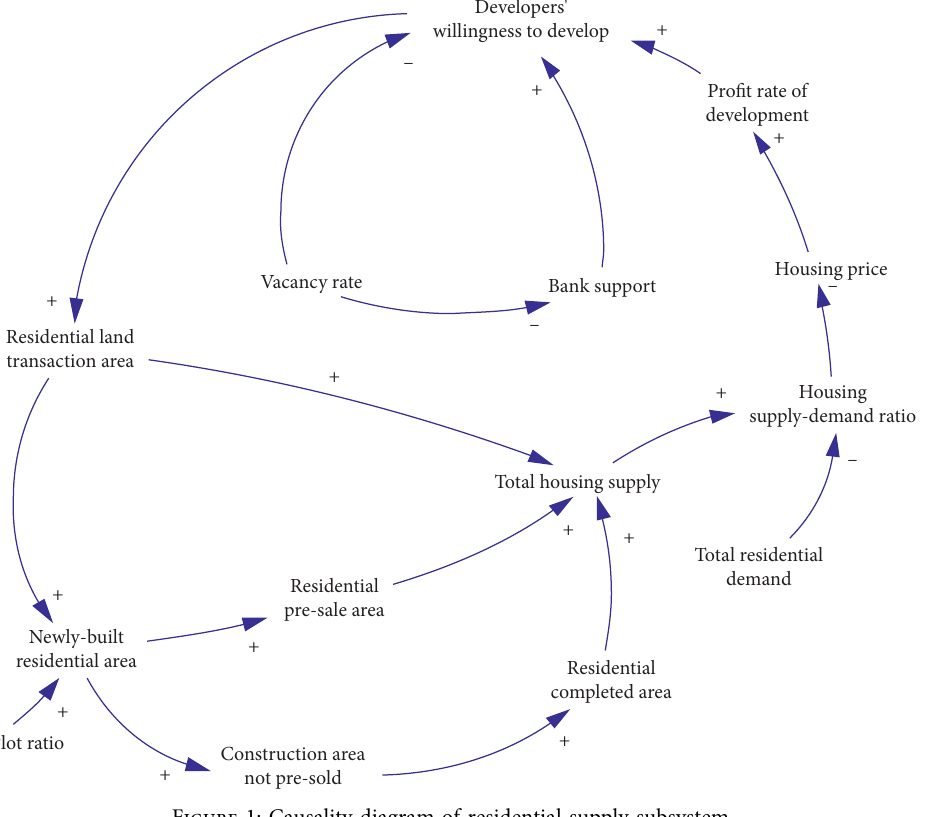
Figure 1: Causality diagram of residential supply subsystem.